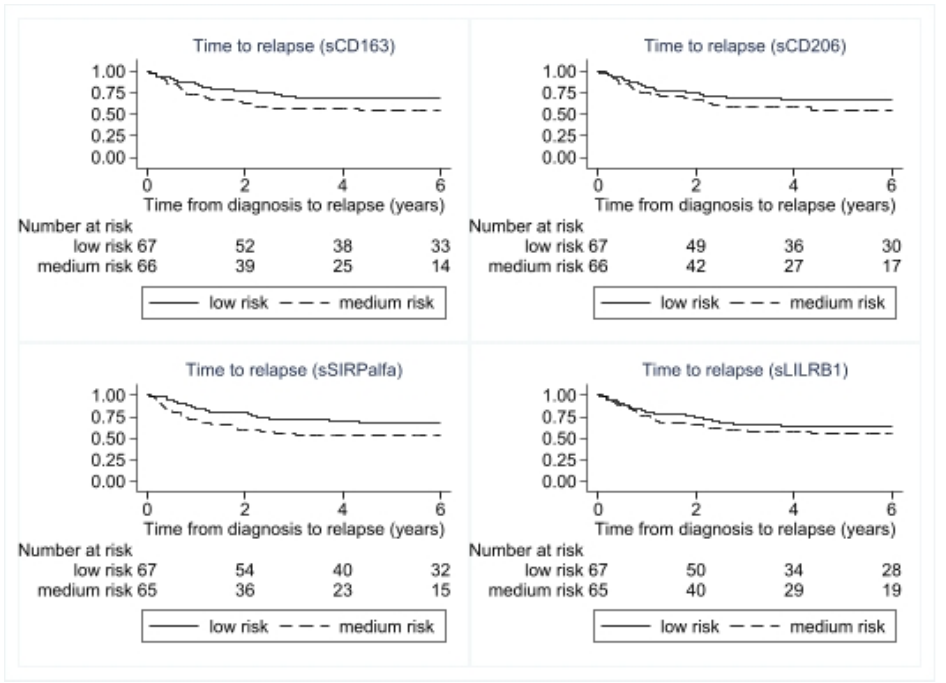
Figure 6. Survival curves for the four different macrophage biomarkers. The macrophage biomarkers are divided into low- and high-risk groups based on median values. Table 2. Univariate analysis for 134 patients with localised disease. Risk of